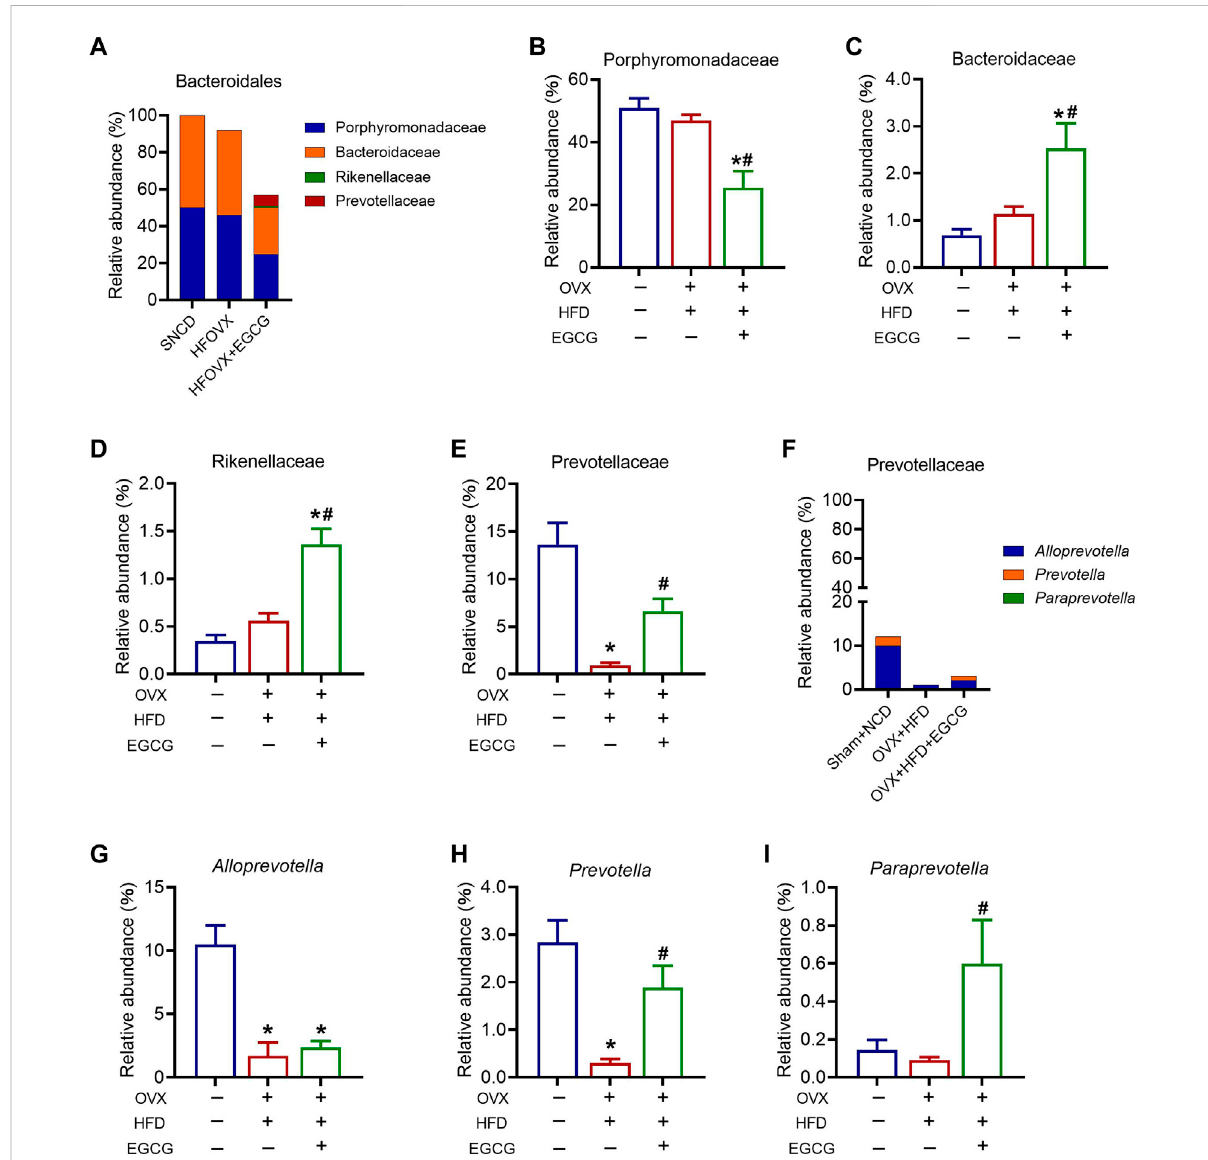
FIGURE 4 DifferentabundancesofgutmicrobiotaattheBacteroideteslevel. (A) Speciespro fi linghistogramofthegutmicrobiotacommunitystructureof Bacteroidales in each group. (B – E) Relative abundance of Porphyromonadaceae (B) , Bacteroidaceae (C) , Rikenellaceae (D) , and Prevotellaceae (E) across the three groups. (F) Species pro fi ling histogram of gut microbiota community structure of Prevotellaceae in each group. (G – I) Relative abundanceof Alloprevotella (G) , Prevotella (H) , and Paraprevotella (I) among the three groups. ** p < 0.01, *** p < 0.001 HFOVX group vs. SNCD group, or HFOVX + EGCG vs. SNCD group; # p < 0.05, HFOVX + EGCG vs. HFOVX group, NS: no statistical signi fi cance; n = 6 – 7